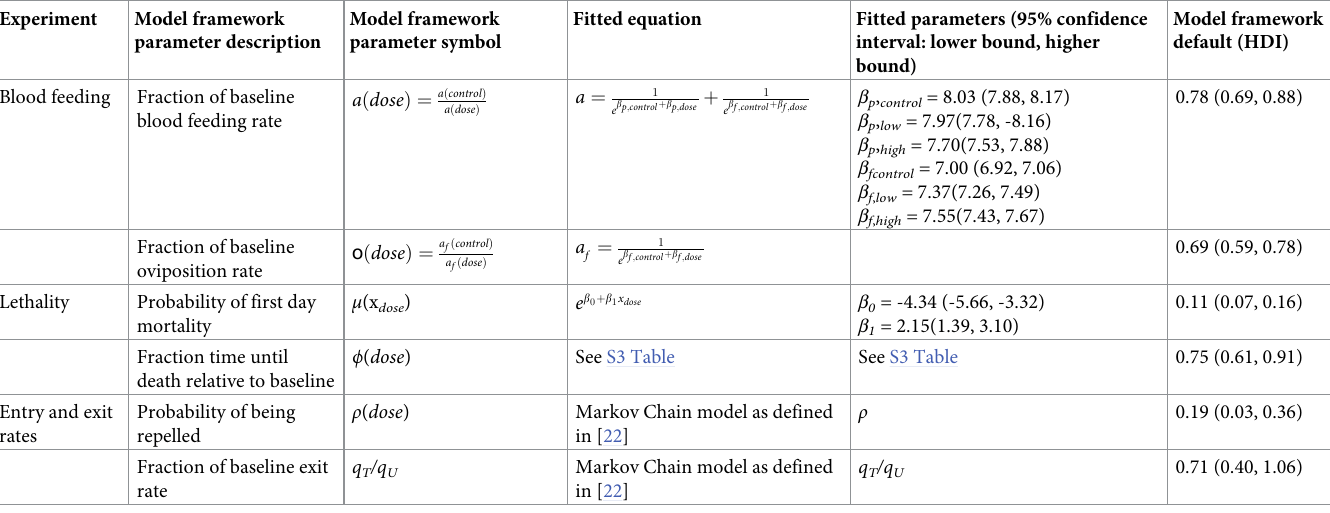
Table 2. Fitted model parameters depicting effects of transfluthrin under experimental laboratory and field